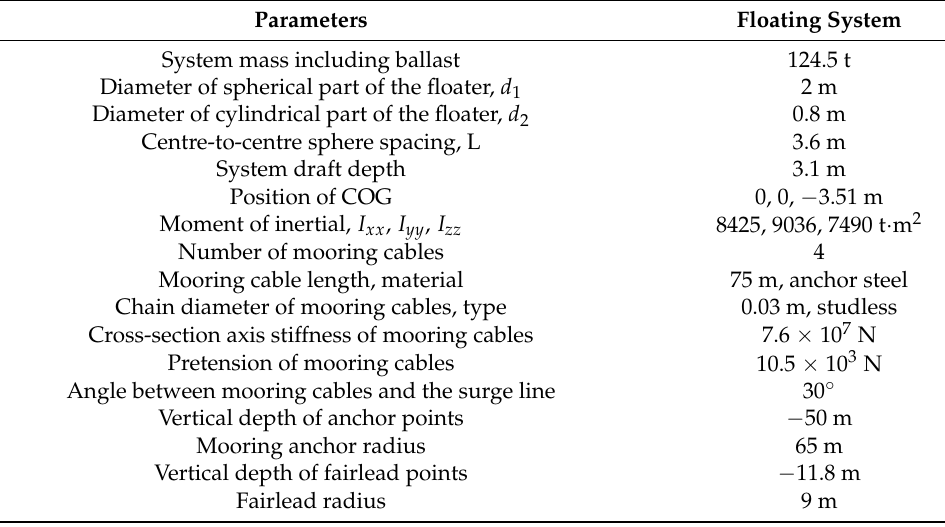
Table 2. Main parameters of the floating system and mooring